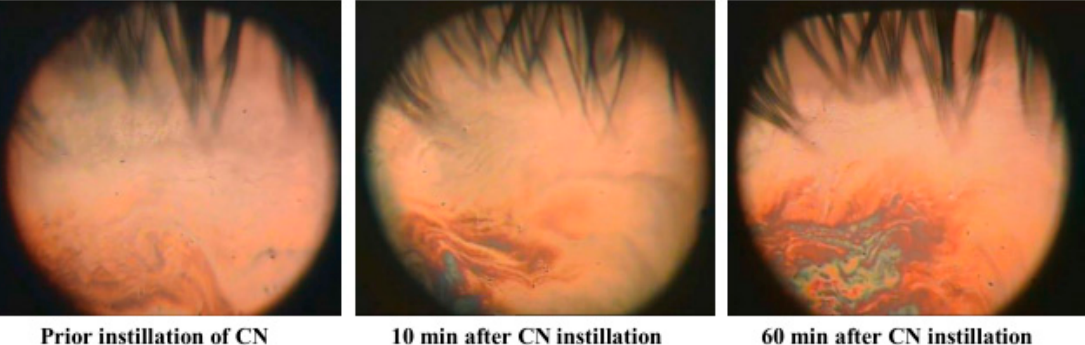
Figure 4. Specular microscopy images of tear film lipid layer prior and after instillation of CN at the ocular surface. (Field of view is approximately 3 cm 2 ).